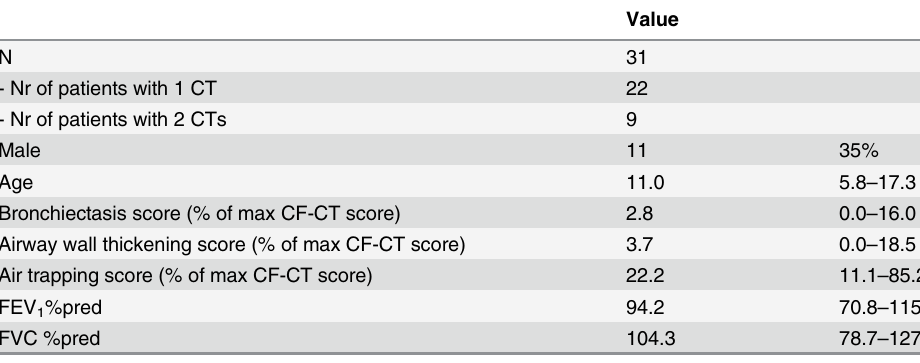
Table 1. Baseline